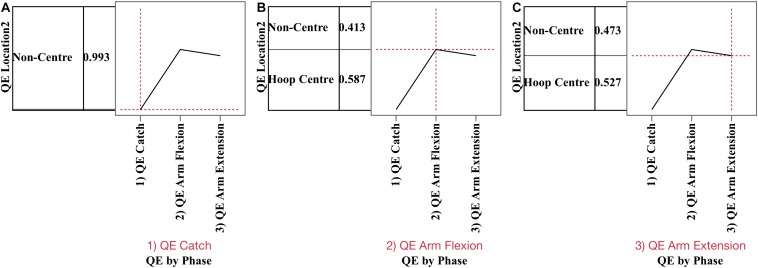
Prediction profiles for phase by location (hoop centre, non-centre) for QE catch (A), QE arm flexion (B), and QE arm extension (C). During (1) QE catch, the probability of not fixating the target was 0.993, due to virtually all fixations being on the ball prior to the catch. During (2) QE arm flexion the probability of the QE being on hoop centre was 0.589 compared to 0.413 for non-hoop locations. During (3) QE arm extension the probability of fixating the hoop centre was 0.527 and non-centric location 0.473.